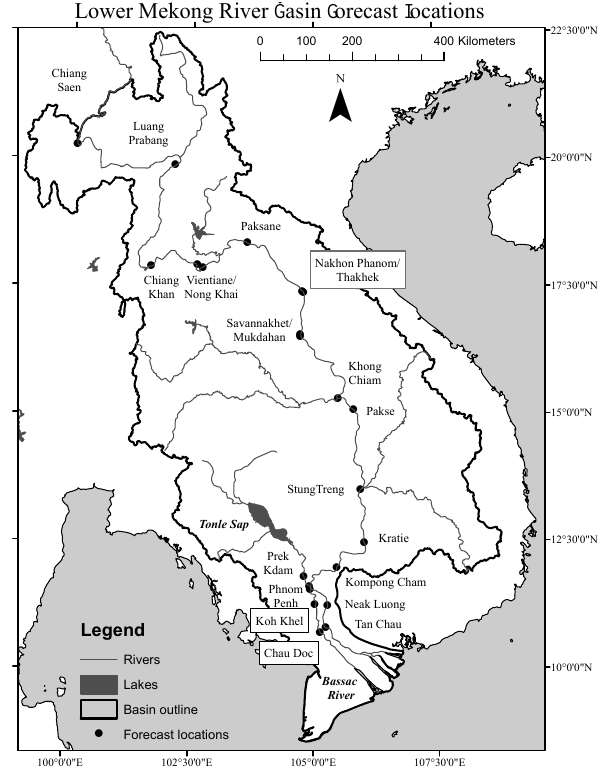
Figure 1. Map of forecast locations (black circles). The river chan- nel, significant water bodies and basin boundary are shown in gray